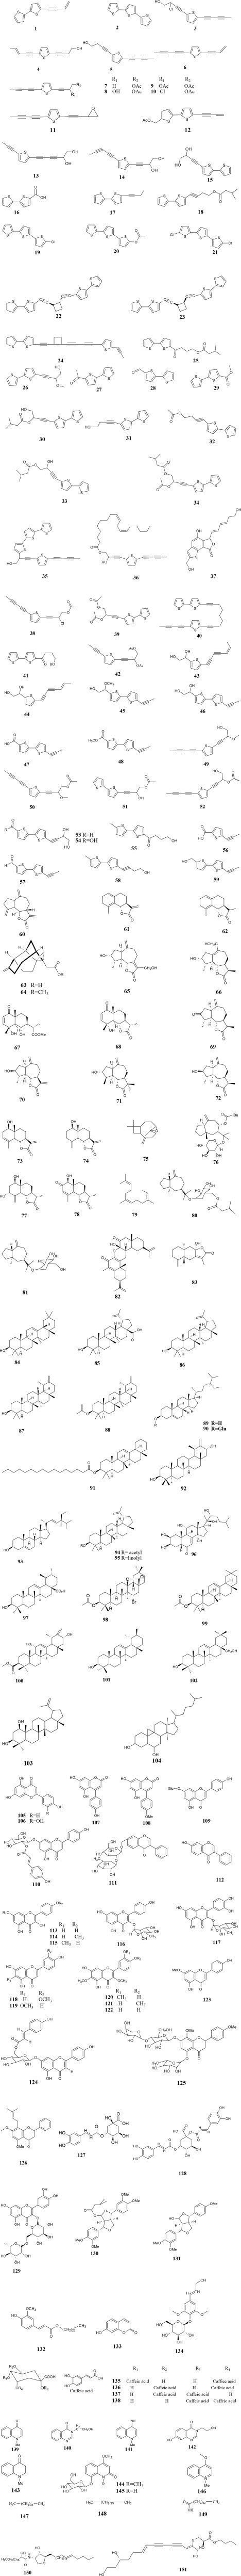
Structural formulae of secondary metabolites isolated from members of the genus Echinops.